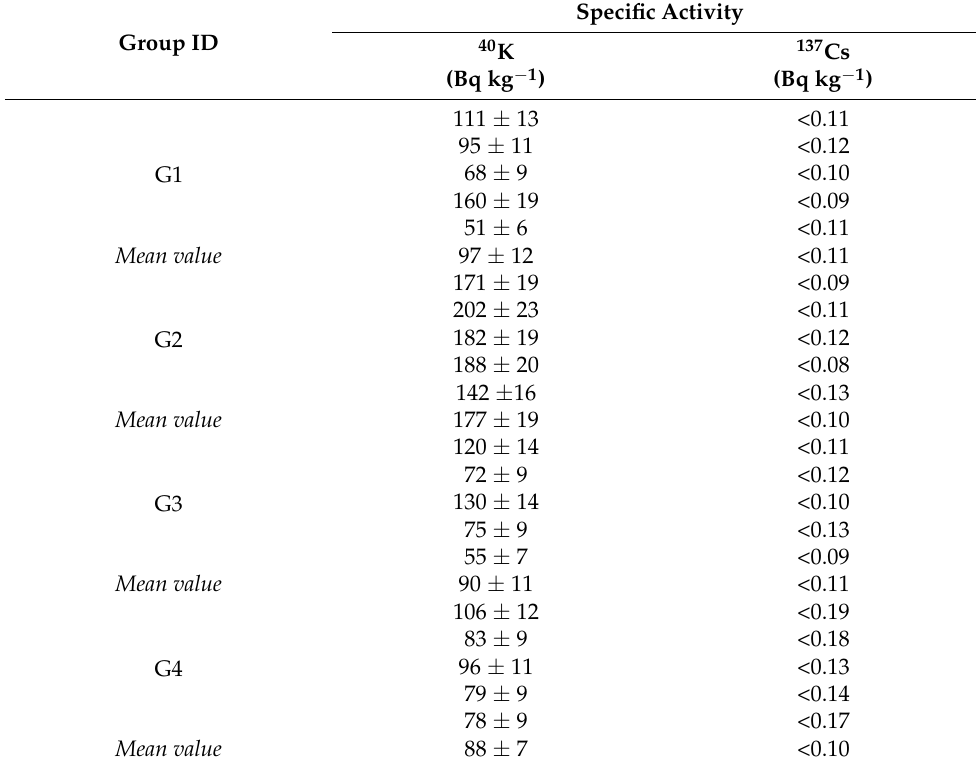
Table 2. Massic activities (Bq kg − 1 ) of 40 K and 137 Cs in the analyzed early childhood food samples.